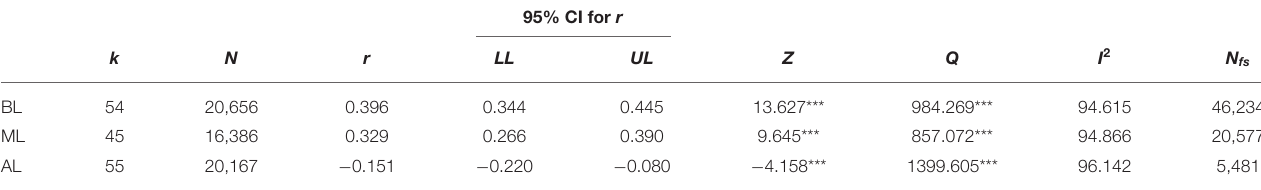
TABLE 3 | Main effects and publication bias tests.